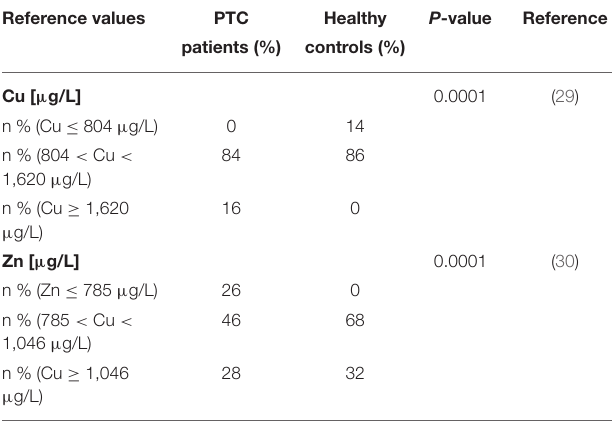
TABLE 2 | Prevalence of elevated Cu and deficient Zn concentrations in PTC patients and healthy controls in comparison to international reference ranges. Reference values PTC Healthy P -value